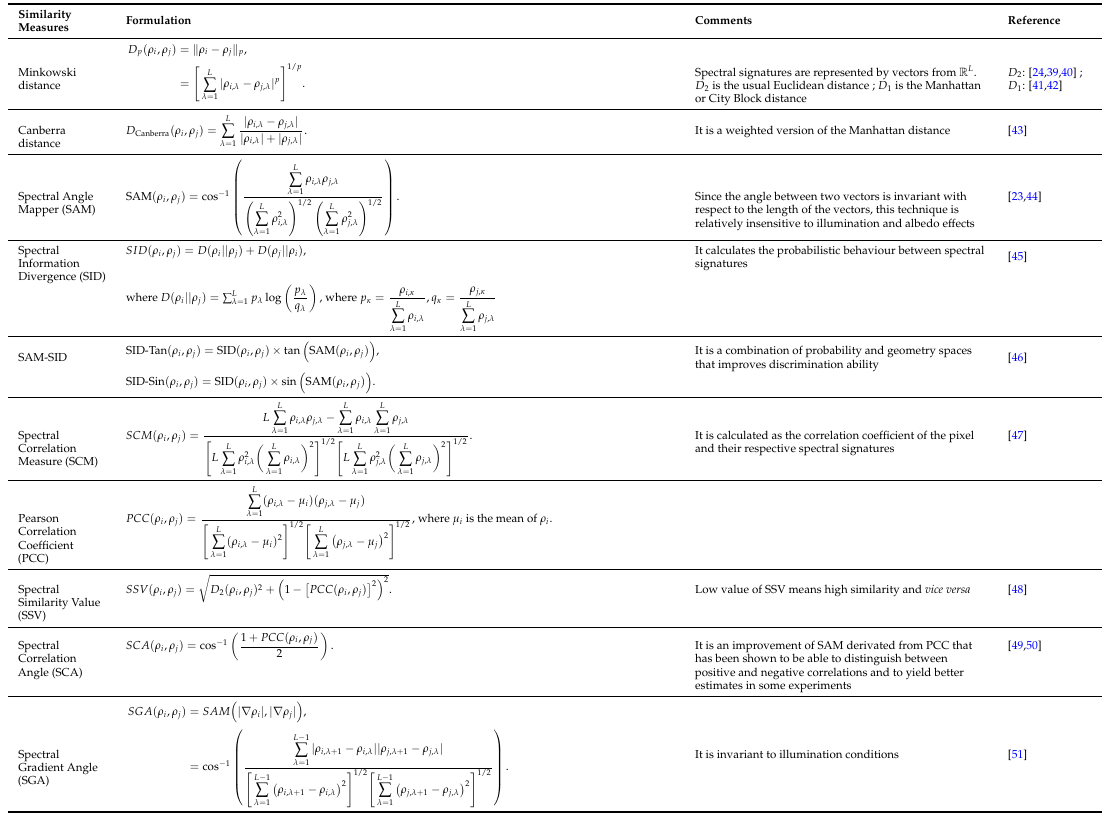
Table 4. Similarity